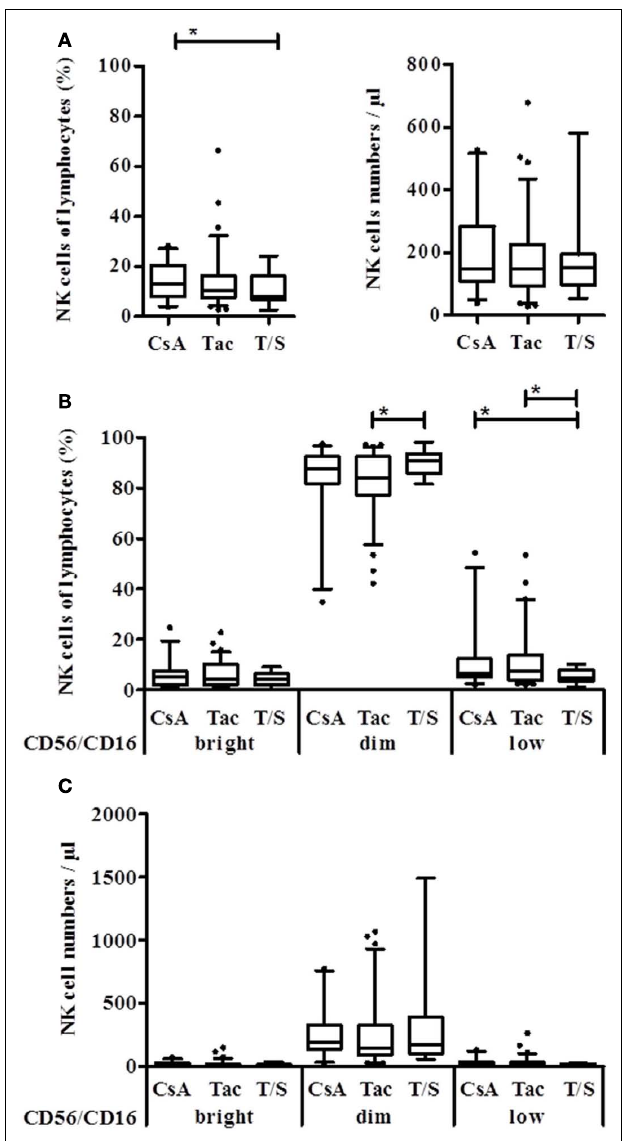
FIGURE 3 | Natural killer cell distribution of KTx-patients is influenced by different immunosuppressive drugs. Kidney transplanted patients were grouped according to the immunosuppressive regimen, i.e., CsA,Tac, or combination ofTac + Sir (T/S) and the NK cell proportion of lymphocytes as well as the number per µ l blood was compared between the groups. (A) Based on their CD16/CD56 PE-staining, NK cells were subdivided into CD56/16 +++ , CD56/16 dim , and CD56/16 low NK cells and calculated as % of lymphocytes (B) or absolute numbers per µ l (C) for each treatment group.